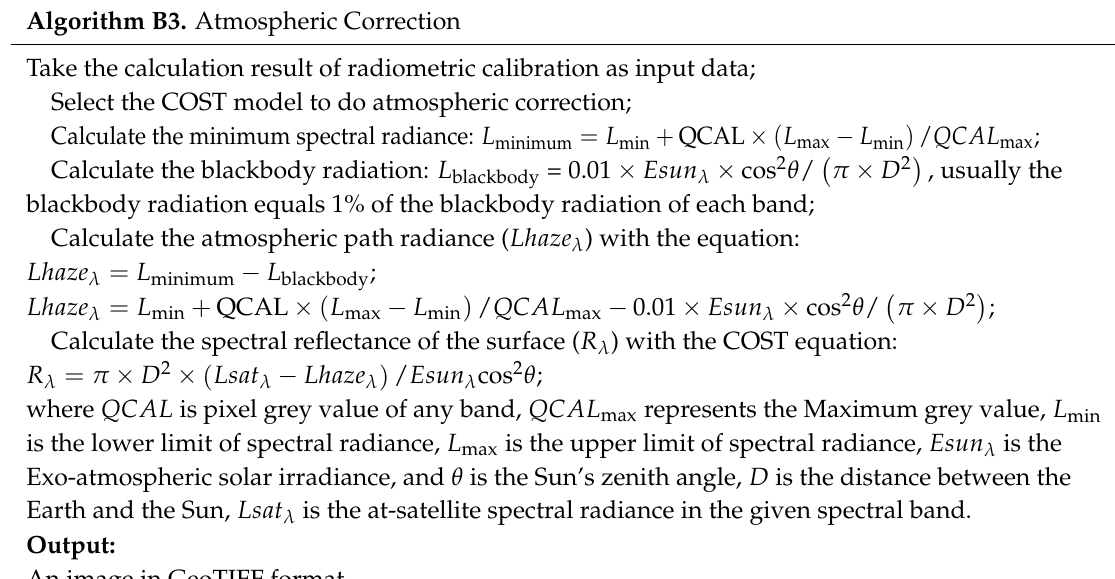
Algorithm B3. Atmospheric Correction